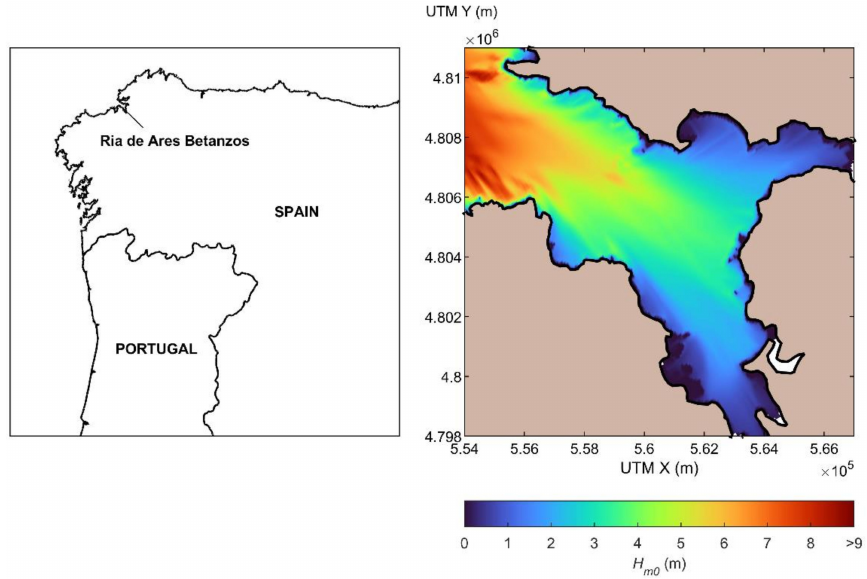
Figure 4. Location of the R í a de Ares-Betanzos in NW Spain (Galicia) ( left ) and spatial distribution of the significant wave height under deep-water wave conditions for T r = 20 (H s = 13.4 m; T p = 16.1 s) and NW direction ( right ) (own source). (Simple column width figure. To be printed in colour in the online version of the paper and in grey scale in the printed